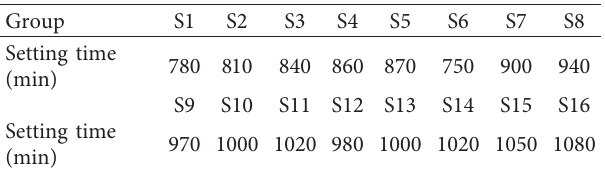
Figure 5: The consistency and fluidity of the waste sediment-based grouting material with different addition amounts of steel slag. Table 5: The setting time of the waste sediment-based grouting